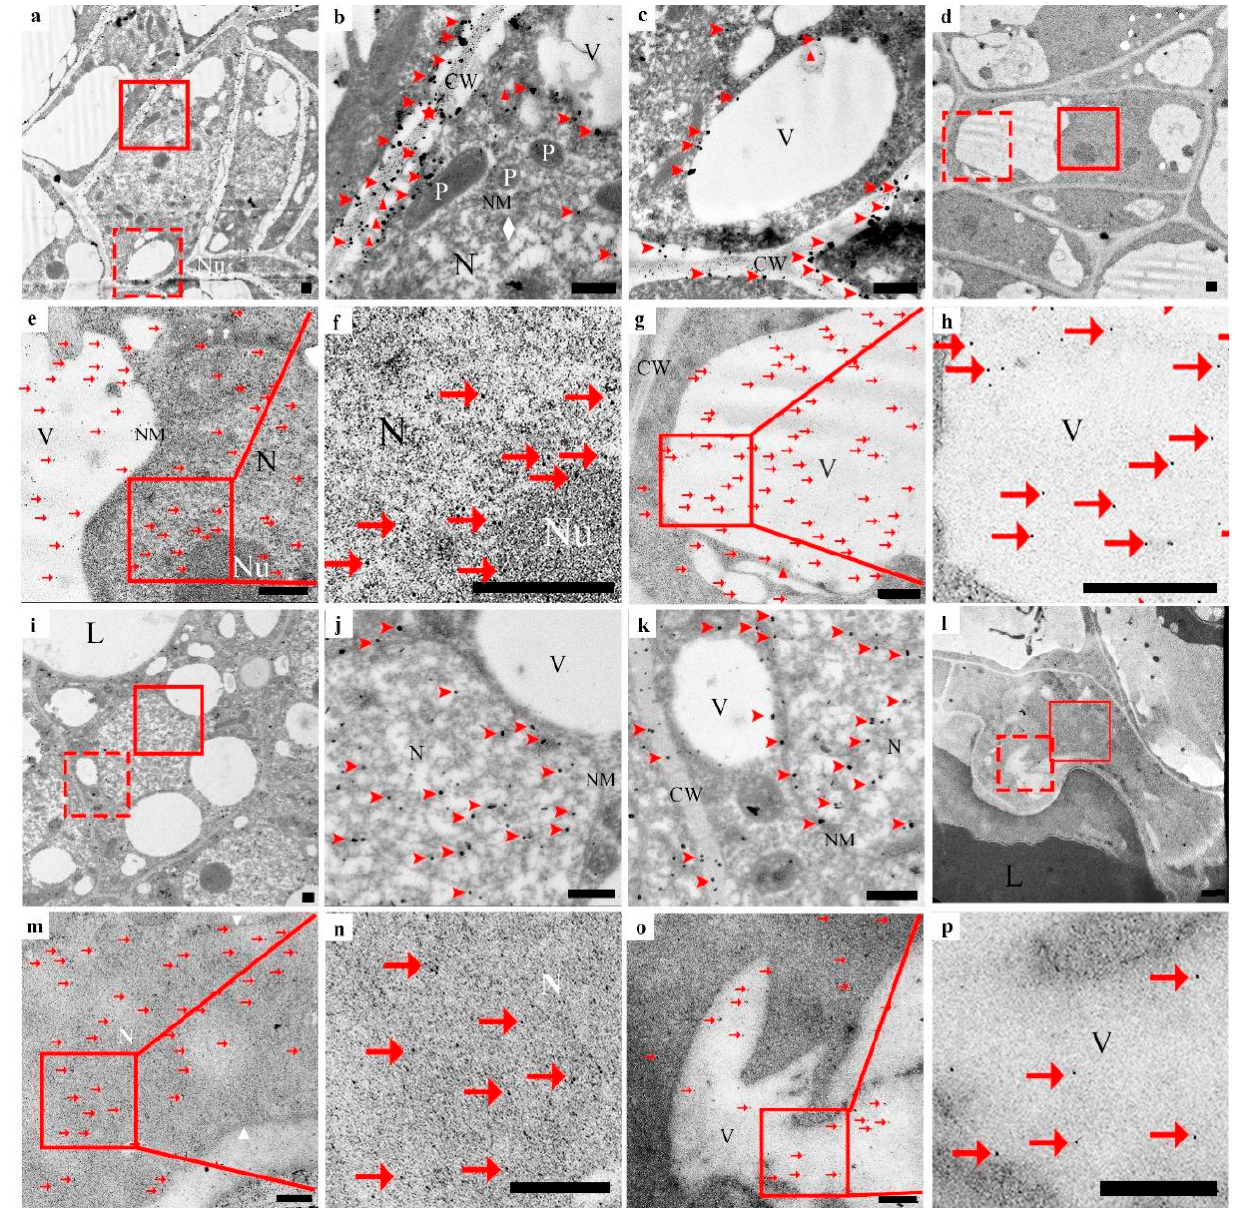
Figure 5. Zn 2+ ions subcellular localization ( a – c , i – k ) and CgENDO1 immunocytochemistry ( d – h , l – p ) during secretory cavity development of Citrus grandis ‘Tomentosa’ fruits. ( a ) Central cells of the globulus of the secretory cavity in the late initial cell stage. ( b ) Shows the solid line rectangle in ( a ). ( c ) Shows the dotted line rectangle in ( a ). The nuclear membrane is partly decomposed, the condensed chromatin has increased (diamond), silver particles by diffusion are entering the cells (arrowhead), and also by phagocytosis (triangle) and plasmodesmata transport (stars) into the vacuole and nuclei (arrowhead). ( d ) Central cells of the globulus of the secretory cavity in the late initial cell stage. ( e ) Shows the solid line rectangle of ( d ). ( f ) Shows the solid line rectangle of ( e ). Degradation of the nuclear membrane decomposition, condensed chromatin (diamond), and a large number of immunogold particles are concentrated in the nucleus, including the nucleoli (arrow). ( g ) Shows the dotted line rectangle of ( d ). ( h ) Shows the solid line rectangle of ( g ), and numerous immunogold particles accumulate in the vacuole. A few are in the cytoplasmic matrix (arrow). ( i ) Shows the innermost secretory cavity cells around the lumen in the lumen-forming stage. ( j ) Shows the solid line rectangle in ( i ), silver particles concentrated in the nucleus residue (arrowhead), and ( k ) shows the dotted rectangle in ( i ). The membrane of the vacuole is degraded. There are silver particles in the cell wall, cytoplasm matrix, and vacuole (arrowhead). ( l ) Shows the innermost secretory cavity cells around the lumen in the lumen-forming stage. ( m ) Shows the solid lines rectangle in ( l ). ( n ) Shows the solid line rectangle of ( m